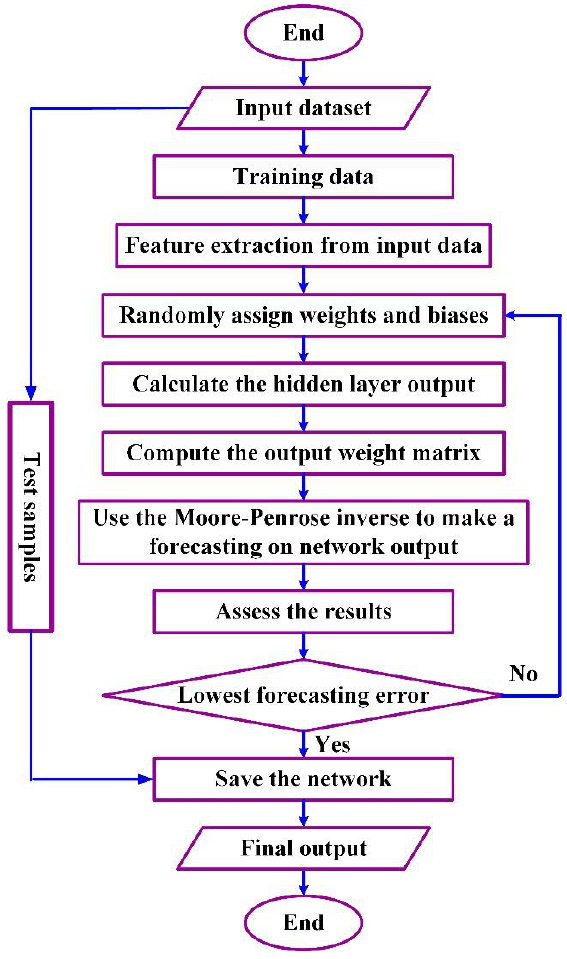
Figure 7. Step-by-step implementation process of the ELM technique.